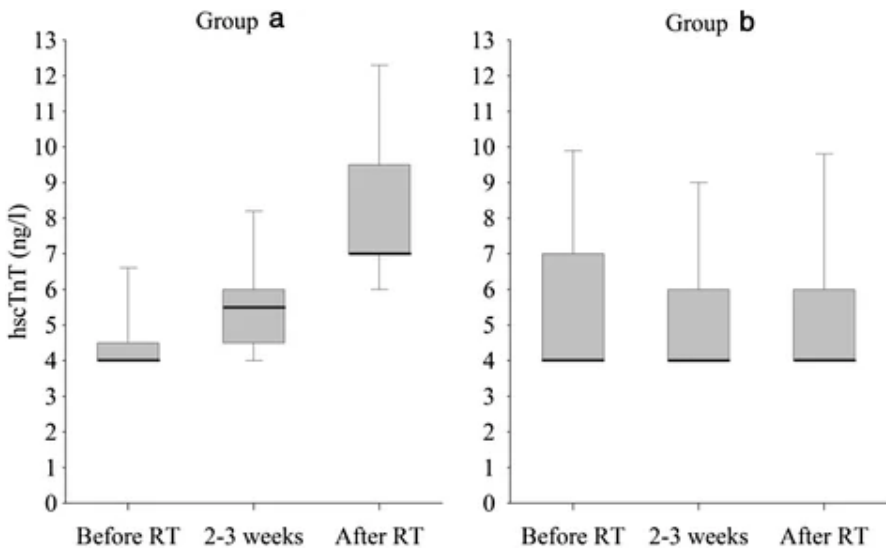
Figure 8. Troponin level variation before, during and after RT in patients treated with higher radi- ation doses and who had a hscTnT increase > 30% from baseline (Group a) versus patients treated with lower radiation doses and who did not experience a significant increase in hscTnT (Group b) [61].